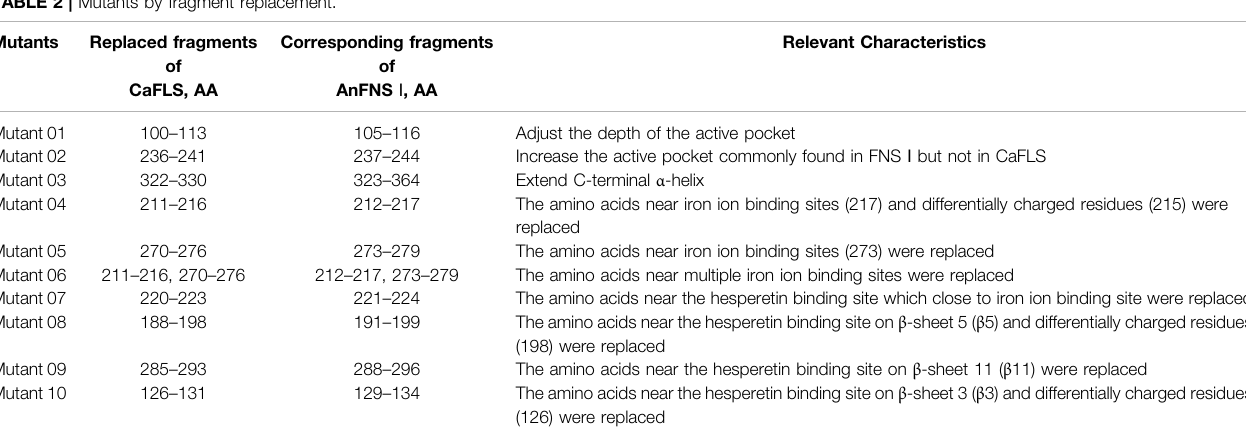
TABLE 2 | Mutants by fragment replacement.